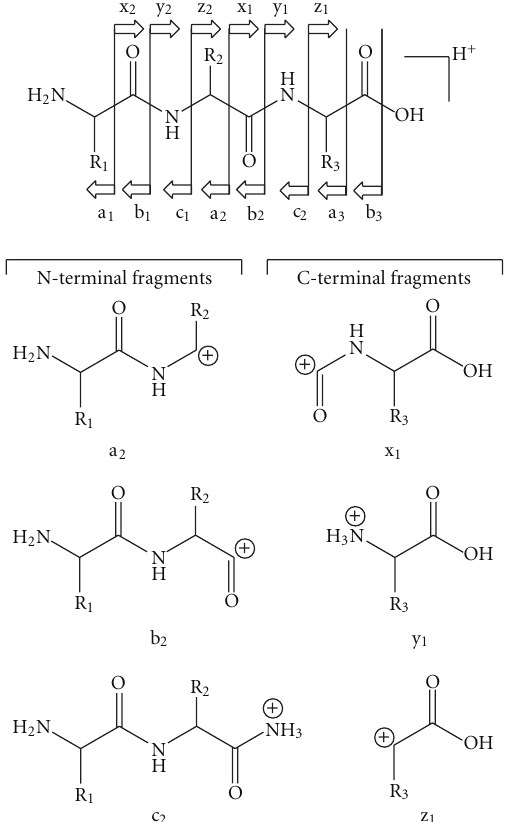
Figure 17: Nomenclature of the peptide fragments showing some typical qualitative structure of the fragments.